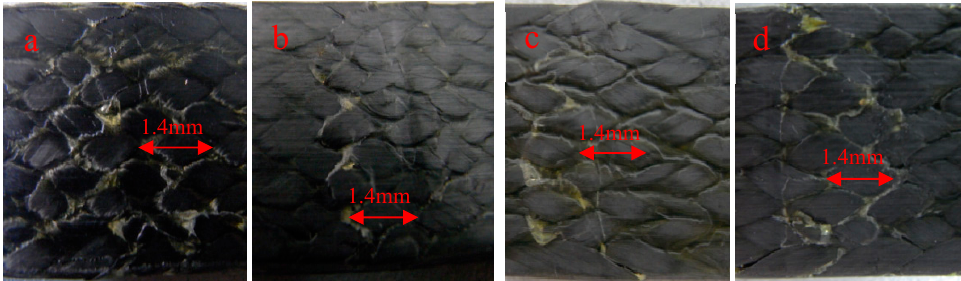
Figure 6. The compression surface morphology of 3Dim–5Dir braided composites with bending fracture at 90 °C and different durations ( a ) at room temperature ( b ) 90 °C 0.25 h; ( c ) 90 °C 10 h; ( d ) 90 °C 30 h.